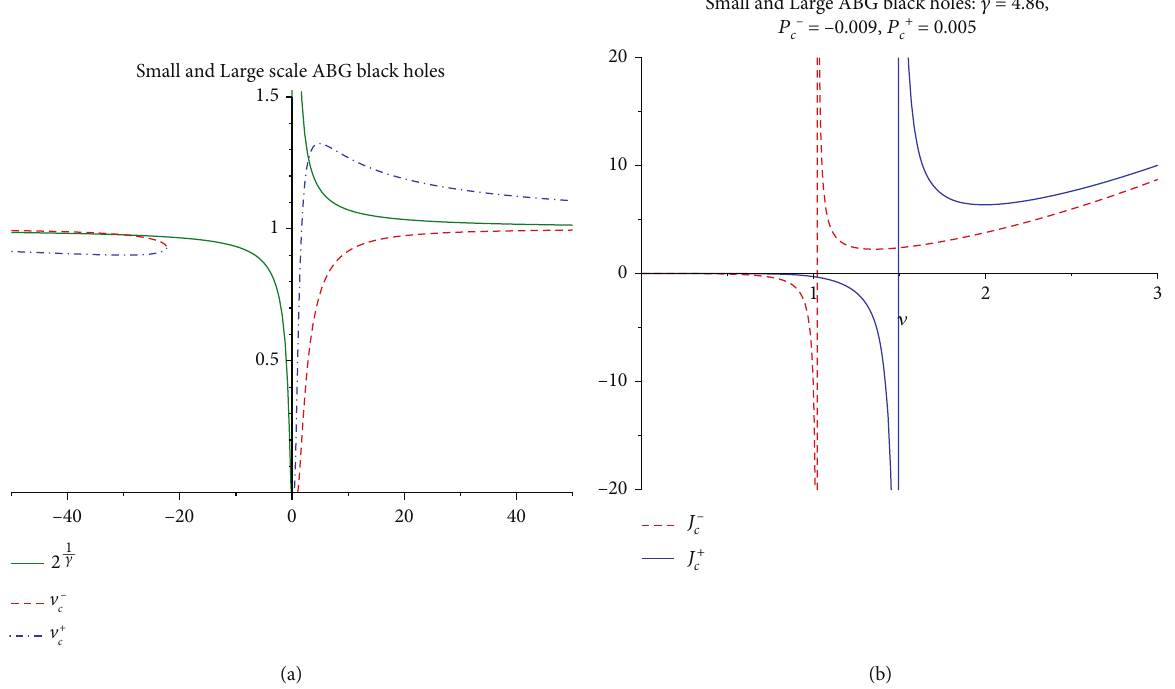
Figure 1: (a) Diagrams of the critical speci fi c volume of small and large generalized ABG black holes vs γ and (b) Variation of entropy per speci fi c volume of small J − = Δ S / Δ v − and large J + = Δ S / Δ v + generalized ABG black